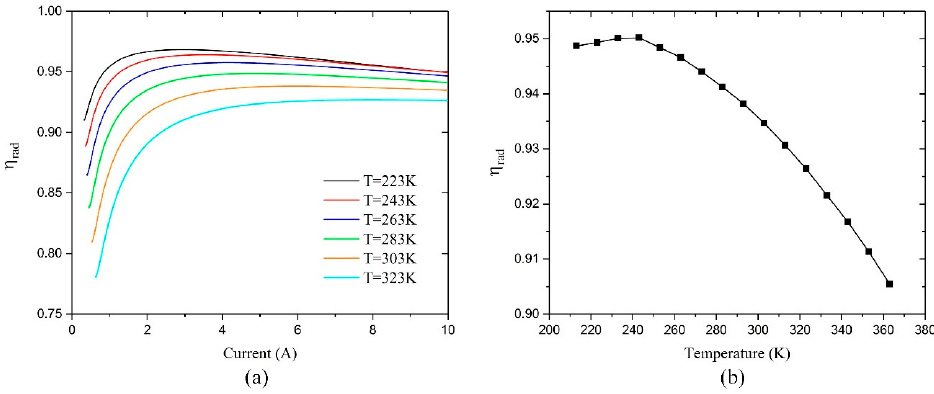
Figure 7. Temperature effects on radiation recombination efficiency ( a ) radiation recombination efficiency vs. injection current at different temperatures ( b ) radiation recombination efficiency vs. temperature at an injection current of 10 A.